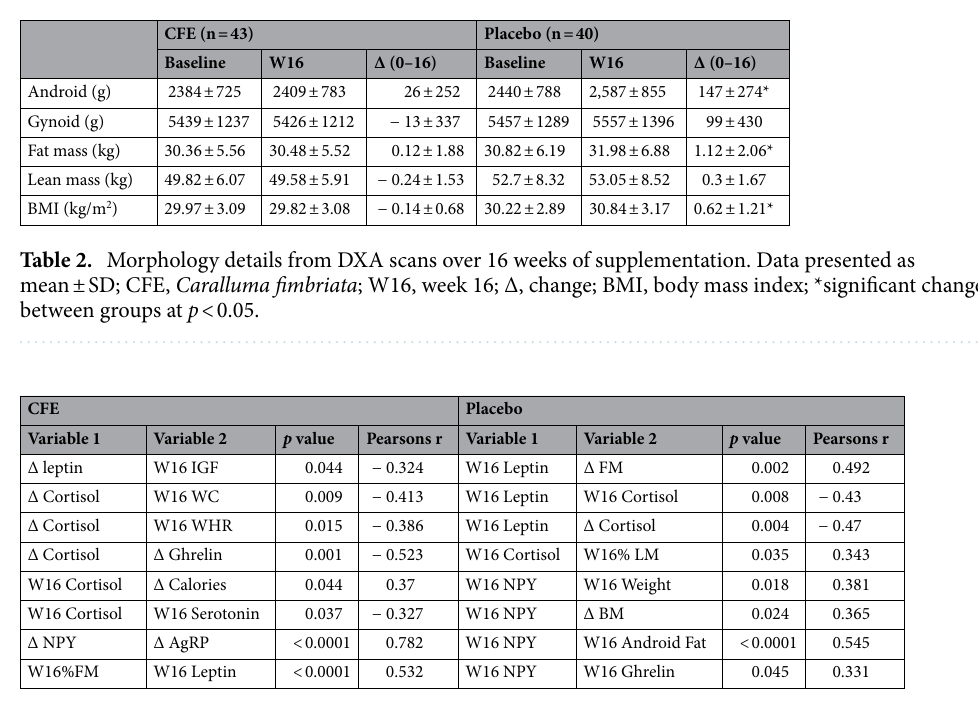
Table 3. Correlation of study variables for the CFE and placebo group. CFE, Caralluma Fimbriata ; Δ, change from baseline values; W, week; FM, fat mass; WC, waist circumference; WHR, waist to hip ratio; LM, lean mass; NPY, neuropeptide-Y; BM, body mass; AgRP, agouti-related